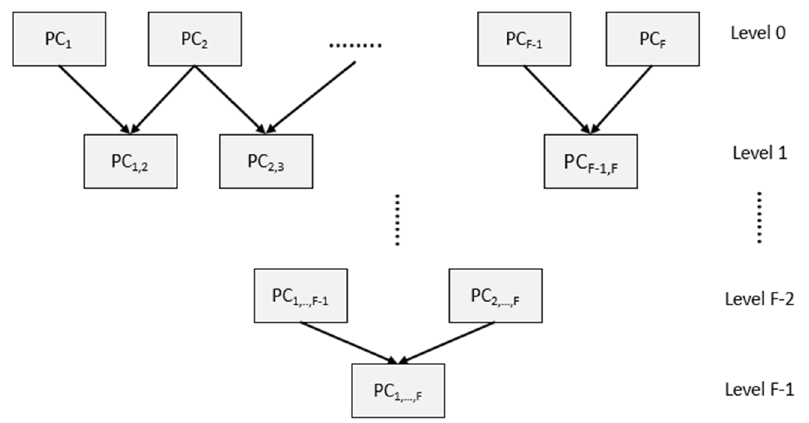
Figure 8. Hierarchical multiple-views registration.